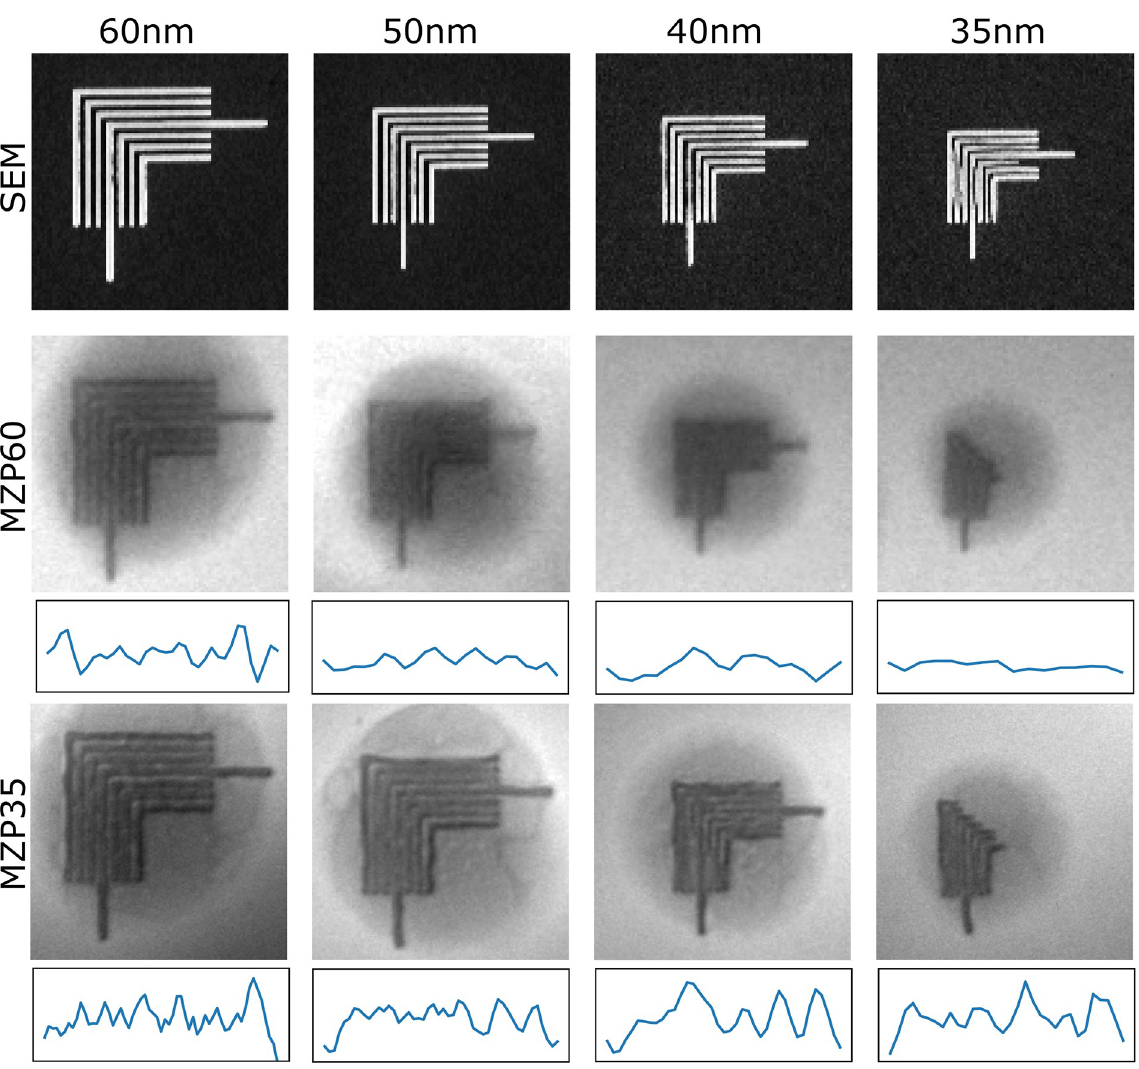
Fig 2. Characterization of 60 nm and 35 nm zone width objectives. Characterization of SXT objectives 60 nm and 35 nm outermost zone width. Top: SEM images of the fabricated test patterns, selected randomly on the supporting membrane. Middle: X-ray projection images of test patterns with 60 nm MZP, and bottom: the same structures visualized with 35 nm MZP. The field of view of x-ray projection images is 1.4 μ m x1.4 μ m. Below each x-ray projection image is a line profile through the test pattern. A spherical background on test patterns is due to remaining